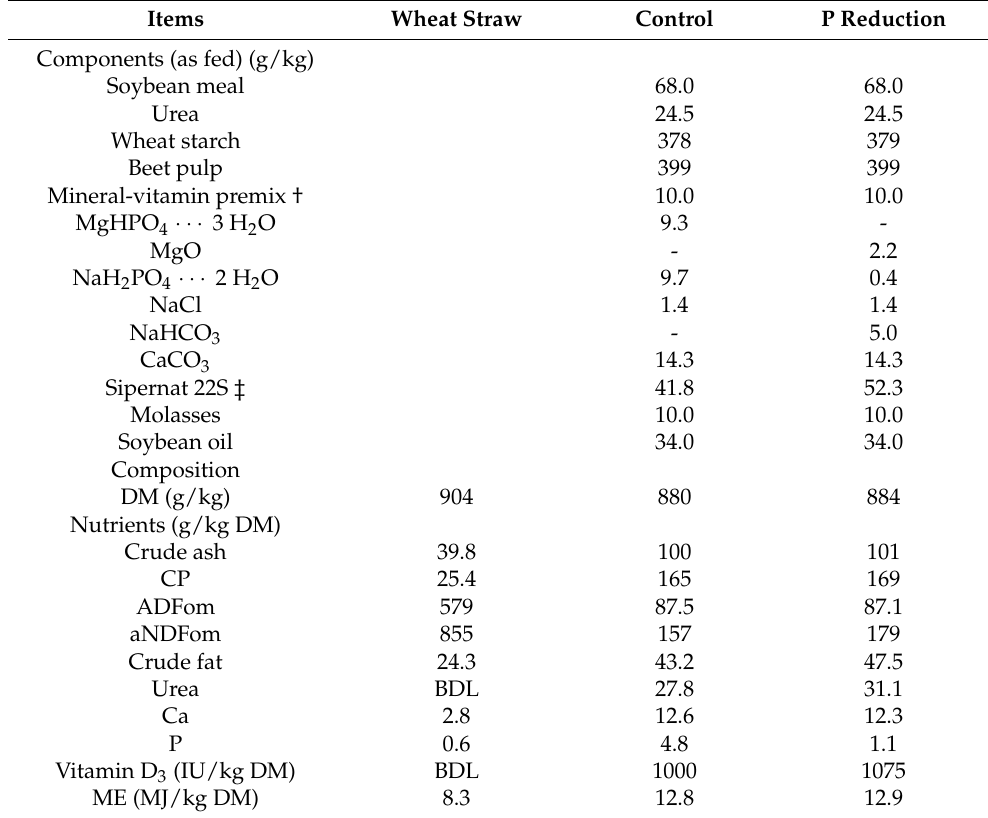
Table 9. Components and composition of wheat straw and pelleted concentrate diets